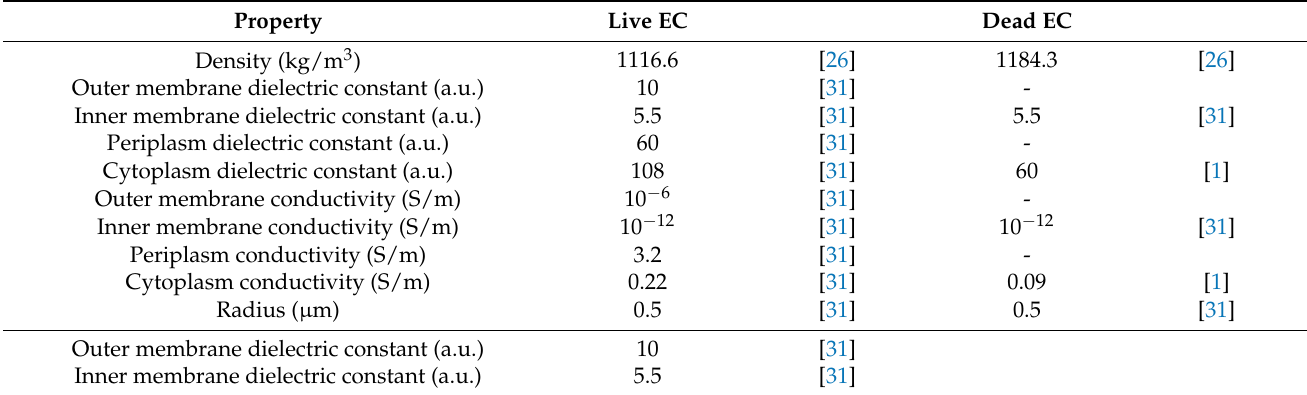
Table 1. Live and dead E. coli properties @ 2 MHz